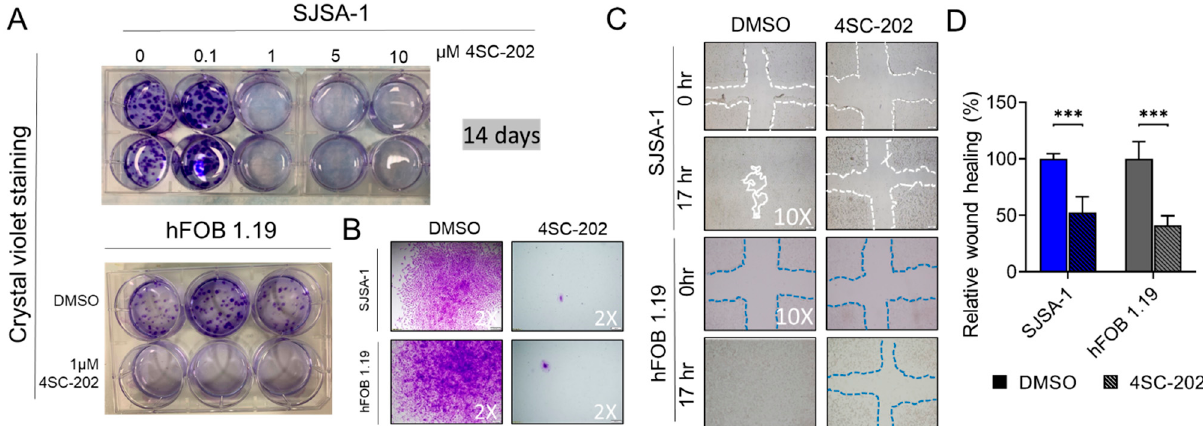
Figure 3. Effect of 4SC-202 on colony formation and wound healing. ( A ) Representative images of crystal violet-stained colonies in wells from SJSA-1 ( top panel) and hFOB 1.19 cells ( bottom left ). Cells were treated with indicated concentrations of 4SC-202 or DMSO vehicle for 14 days. ( B ) Representative images of colonies under microscope with 2× objective magnification. ( C ) Representative images of wound healing at indicated hours after the mechanical scratch under 10× objective magnification from SJSA-1 ( top panel) and hFOB 1.19 cells ( bottom ). Left : vehicle, right : treated with 4SC-202. The white and blue lines indicate the edges of the wounded area. ( D ) Quantitative analysis of the wound healing area after the scratch. Wound healing area of vehicle-treated cells is defined as 100% versus areas of drug-treated cells (*** p < 0.001). Data are presented as mean (SD).